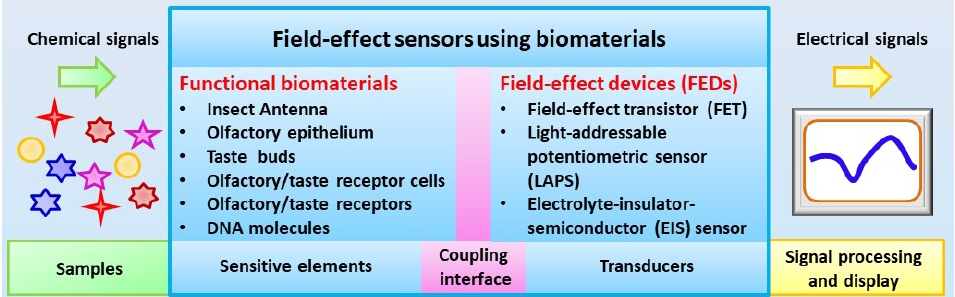
Figure 1. Schematic diagram of configurations of field-effect sensors using biomaterials.